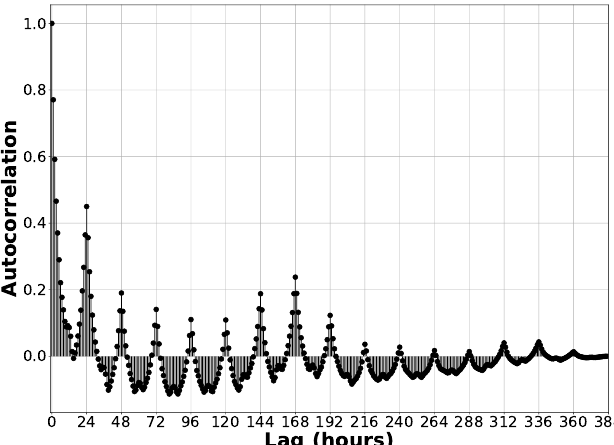
Figure 5. Average autocorrelation of the FCR-N prices